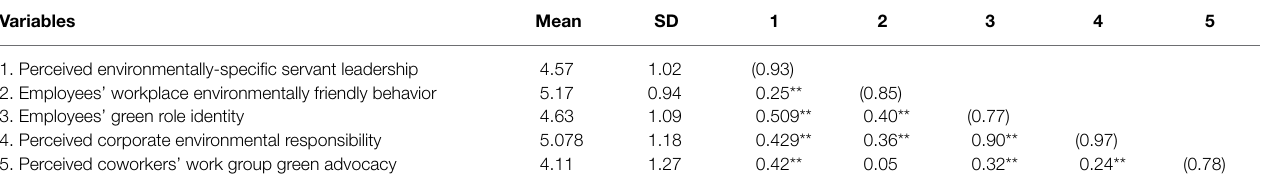
TABLE 2 | Descriptive statistics and correlations among